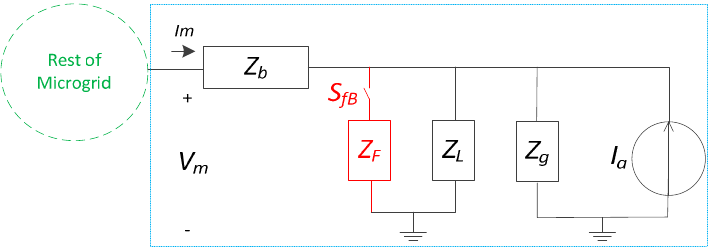
Figure 4. Equivalent impedance-based model for when all switches of Figure 3 are open (normal operation) and during a faulted condition between the load and cable ( S fB closed).